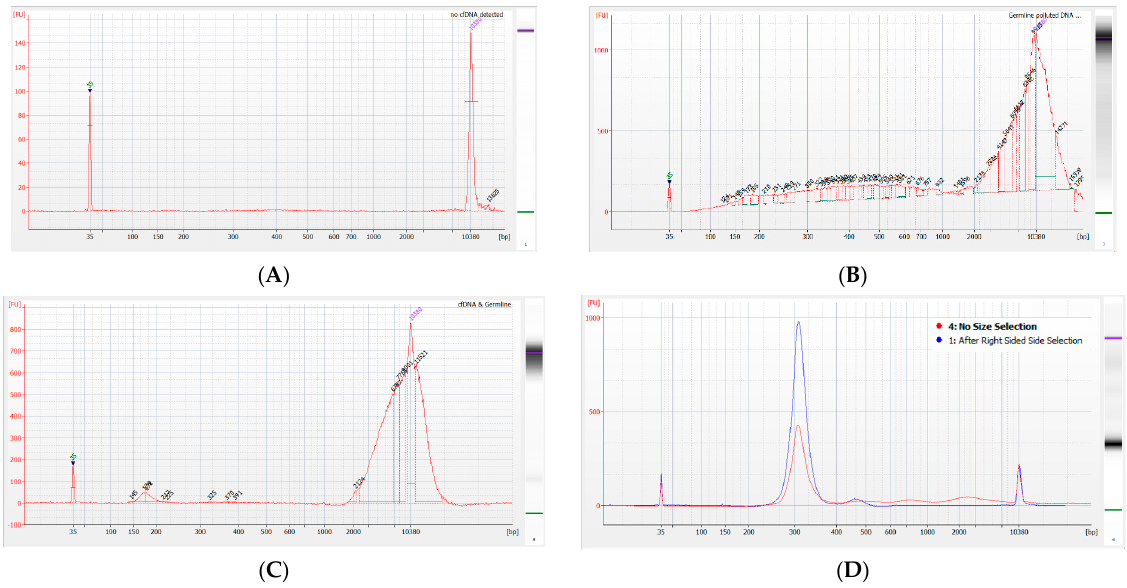
Figure 4. Bioanalyzer electropherograms illustrating quality control of ccfDNA after isolation and right-sided size selection. ( A ) ccfDNA sample containing no detectable material and excluded from the study; ( B ) ccfDNA sample that is strongly contaminated with fragmented genomic DNA and excluded from the study; ( C ) ccfDNA sample that contains some genomic DNA contamination and passed quality control; ( D ) ccfDNA derived libraries prior to hybridization and post first PCR, before (red) and after (blue) right-sided size selection.